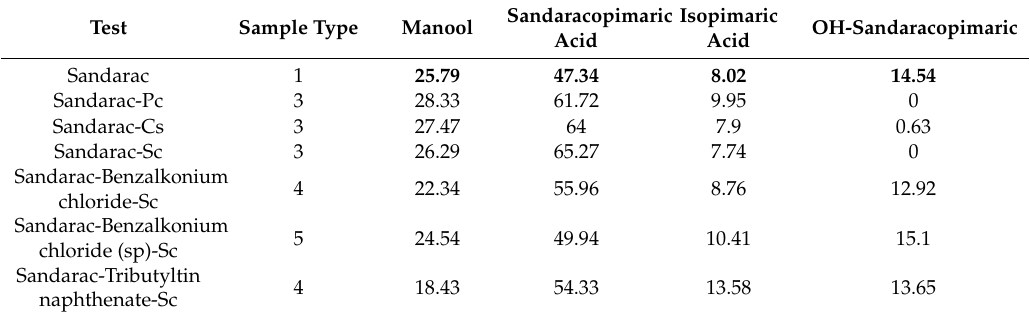
Table 3. GC-MS analysis ( p < 0.05 in all cases) of the diterpenes in the sandarac varnish and the samples inoculated with microorganisms (values expressed in Ni